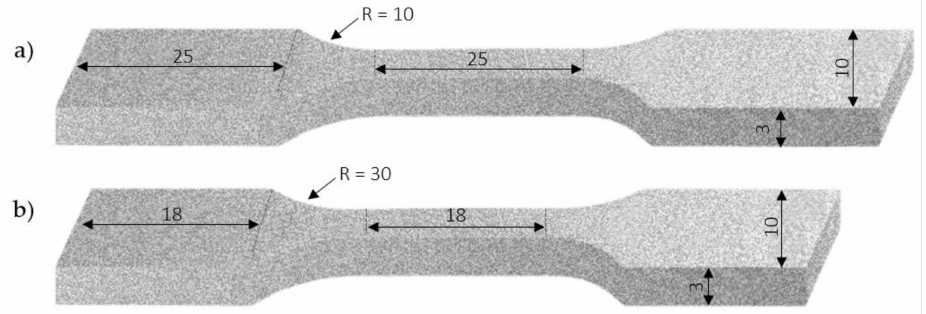
Figure 1. Shape and dimensions (in mm) of ( a ) tensile and ( b ) fatigue